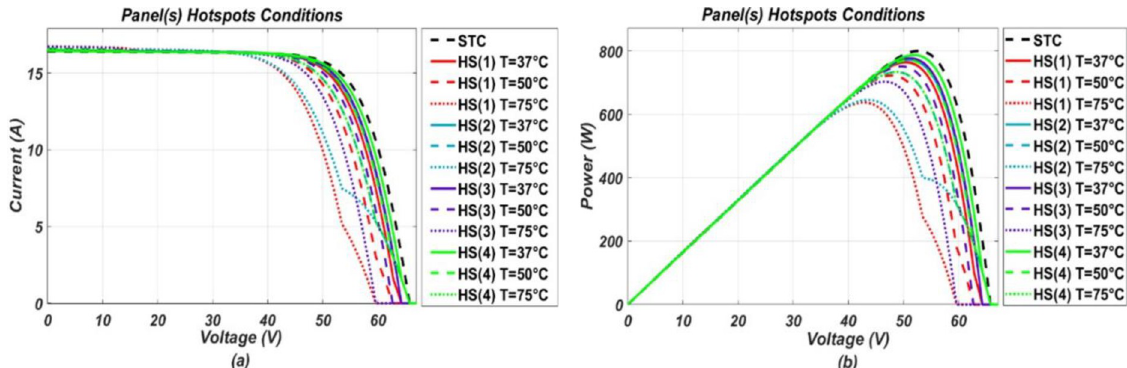
Fig 4. (a) and (b), I-V and P-V graphs respectively, representing response of the P.V. system under panel(s) hotspots conditions of different intensity levels.